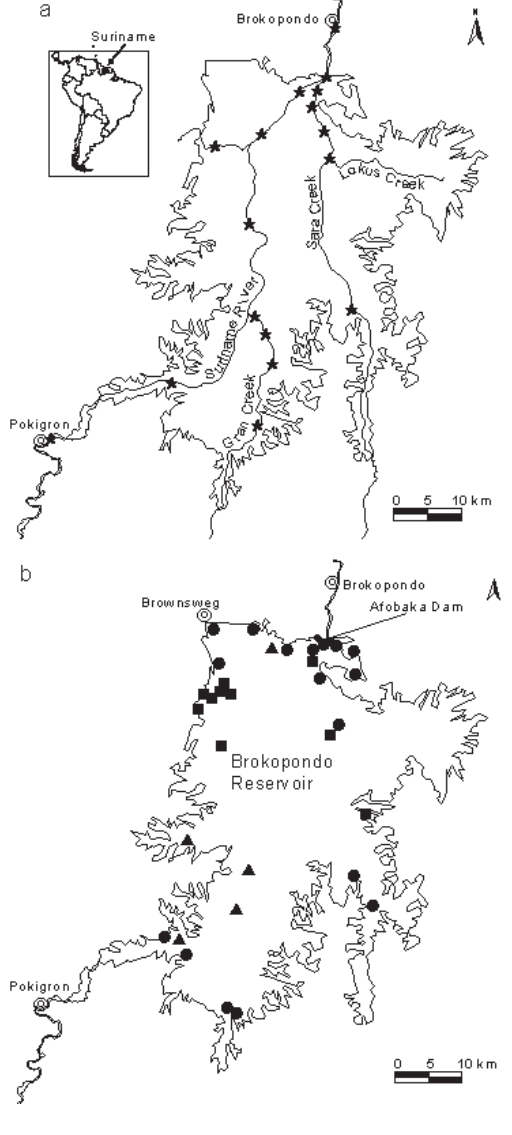
Fig. 1. Location and morphometry of Brokopondo Reservoir in Suriname showing fish sampling sites. (a) Former courses of the Suriname River and tributary streams in Brokopondo Reservoir area with pre-impoundment sampling sites (1963- 1964; stars); outline of future Brokopondo Reservoir in grey. (b) Brokopondo Reservoir with sampling sites of fish sur- veys during filling stage (1965-1967; dots) and post-impound- ment stage ([1978; triangles] and [2002-2005; squares]). The numerous small islands in the reservoir are